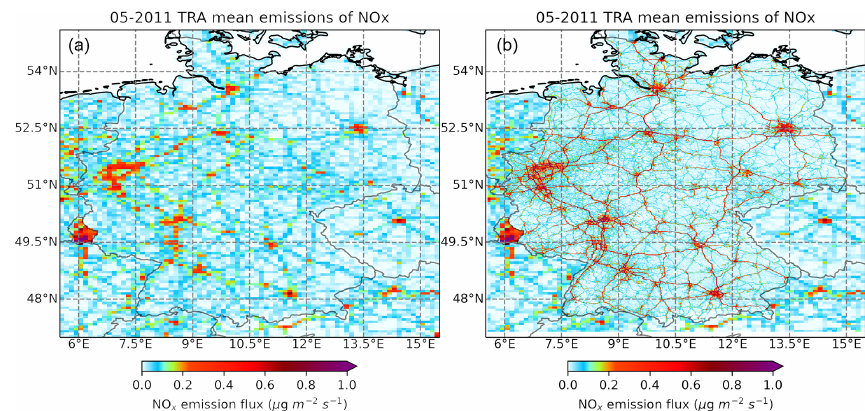
Figure A2. NO x emission flux from the road transport sector for (a) TNO MACC III emissions for May 2011 (Kuenen et al., 2014) and (b) composite UBA with Germany (May 2018) and TNO MACC III emissions outside Germany (May 2011).